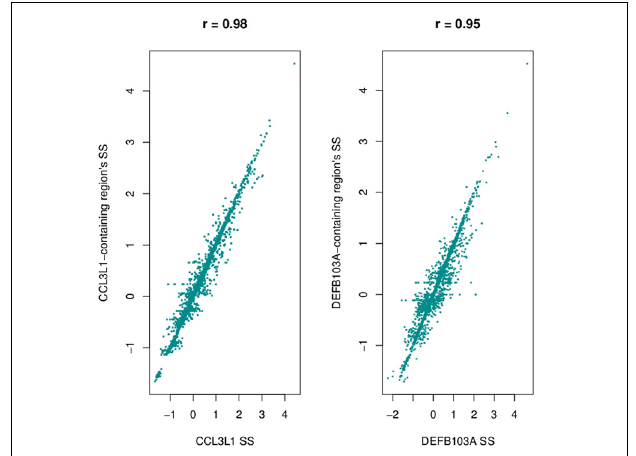
FIGURE 8 | Correlation between segmentation scores of CCL3L1/DEFB103A and polymorphic regions encompassing the genes.